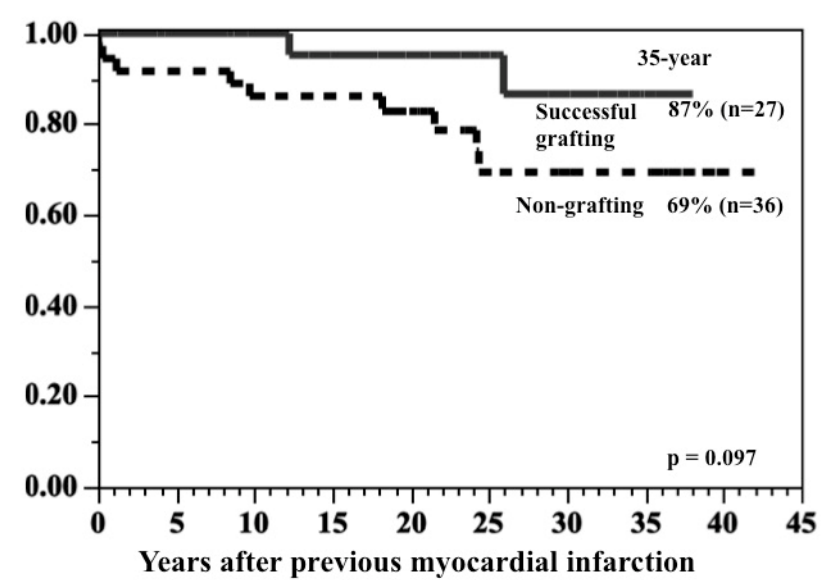
Figure 6. Comparison of survival rates of patients with previous myocardial infarction between the successful CABG group and nongrafting group.